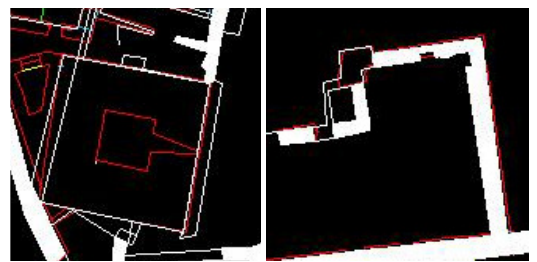
Figure 7: Some differences between the two maps, due to low resolution surveying but also structural changes (in white the more accurate and detailed range-based results).